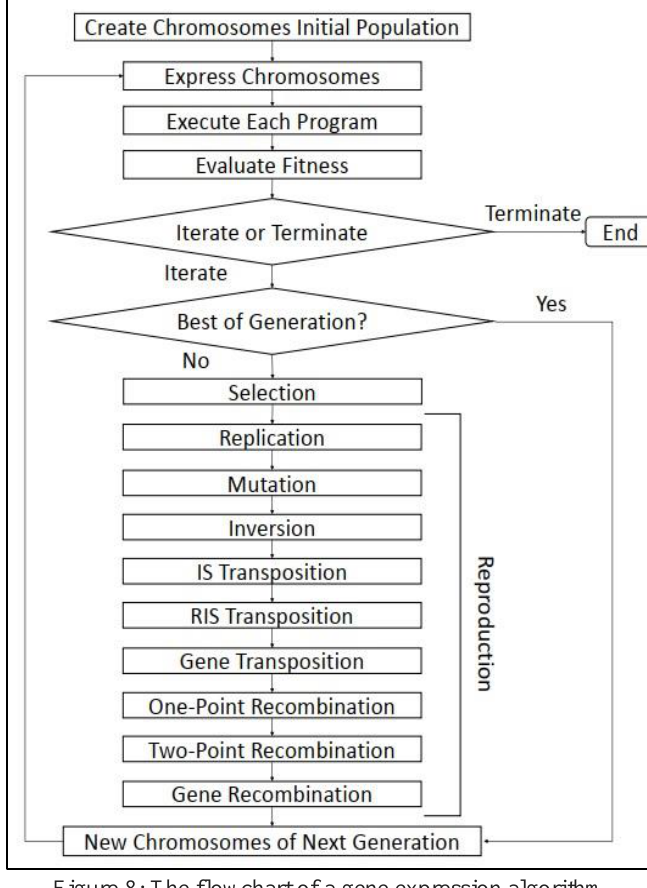
Figure 8: The flowchart of a gene expression algorithm. Source: [9].